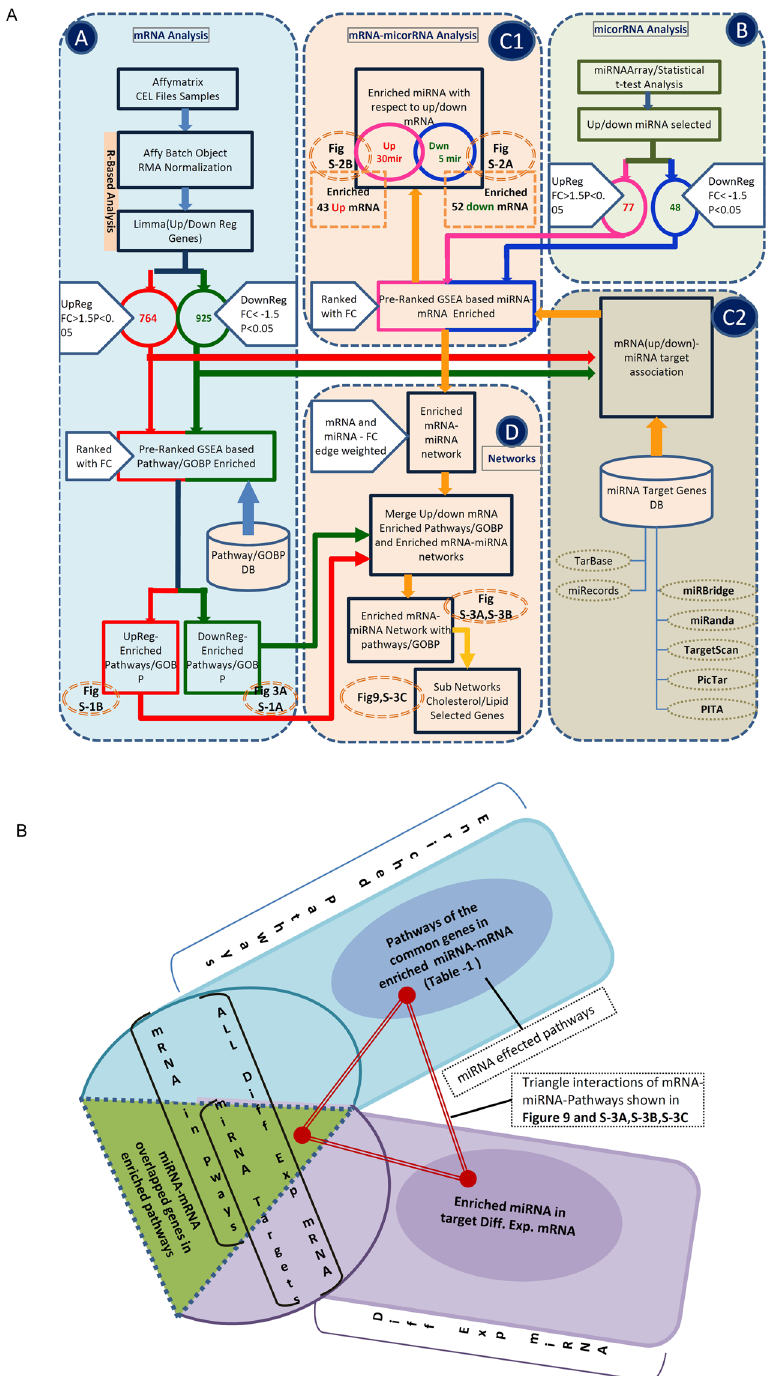
Figure 1. Integrated flow diagram of the mRNA and miRNA analysis. Color code: green and red color lines are for the down and up regulated mRNA analysis flow respectively; blue and pink lines are for the down and up regulated microRNA analysis flow respectively. The orange lines depict the mRNA-miRNA enrichment and network analysis flow. The numbers in the circles show the number of up/down regulated mRNA or miRNA. The figure numbers indicated in the dotted circles with orange color are where the output results of these analysis blocks are shown. Block ( A ) shows the differential gene expression analysis and pre-rank GSEA based transcriptome data processing, pathways and GO biological process (GOBP) enrichments. The flows in red and green show the pathways/GOBP enrichment for the up and down regulated genes analysis respectively. The numbers in the circles show the number of differentially expressed up (red) and down (greed) genes with the selected FC > 1.5 and p-value < 0.05. The bottom part shows the flow of pathway enrichment analysis using the KS statistics using GSEA 50 . Block ( B ) shows the microarray data analysis of miRNA. The t-test is used to obtain the differentially expressed miRNA as shown in the circles up (pink) and down (blue) with the